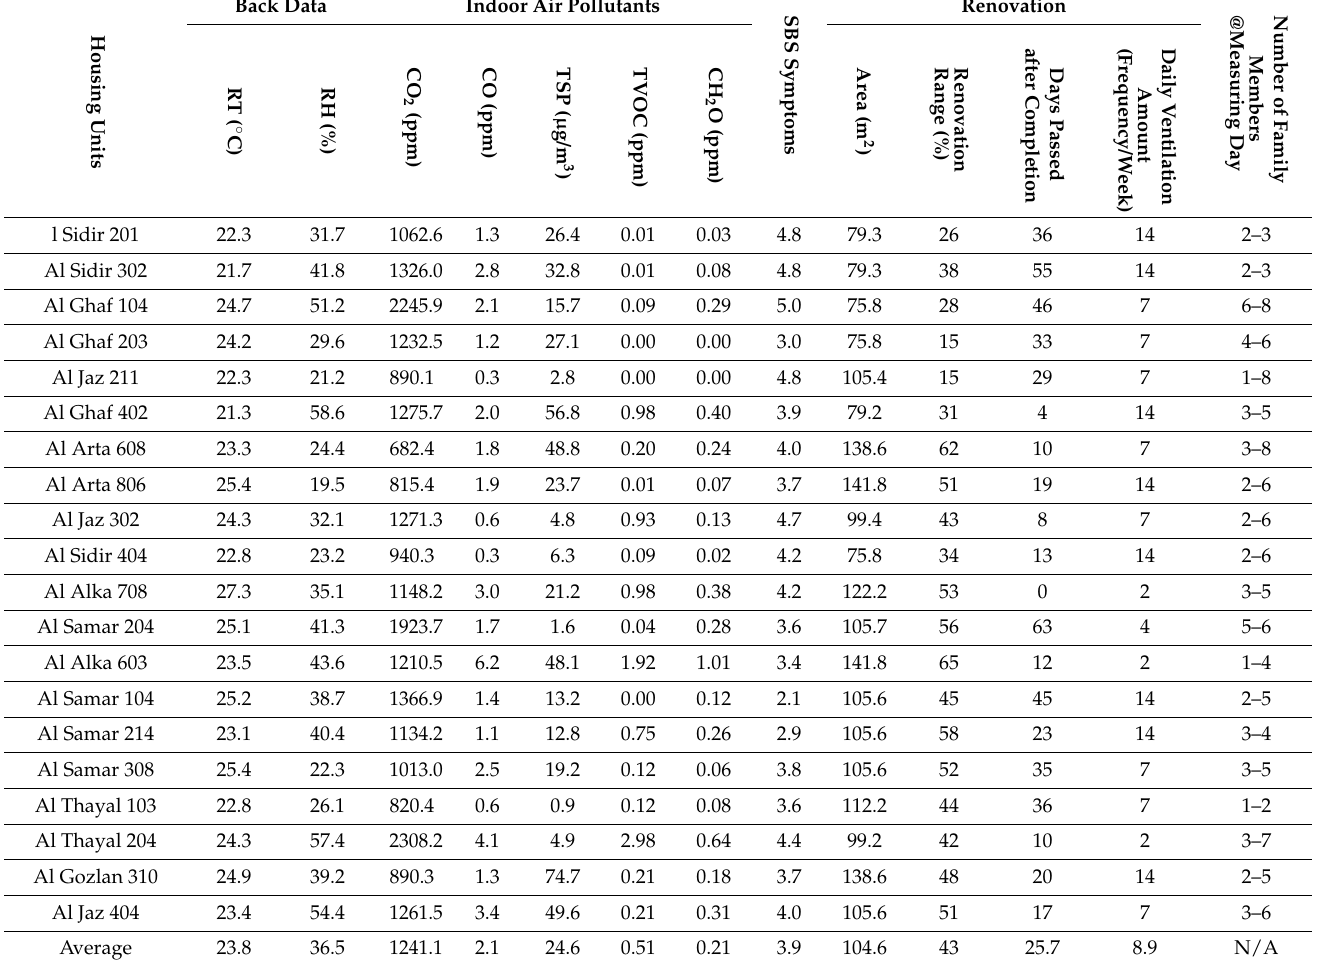
Table 8. Field survey results and indoor air pollutants in 20 housing units at The Greens,